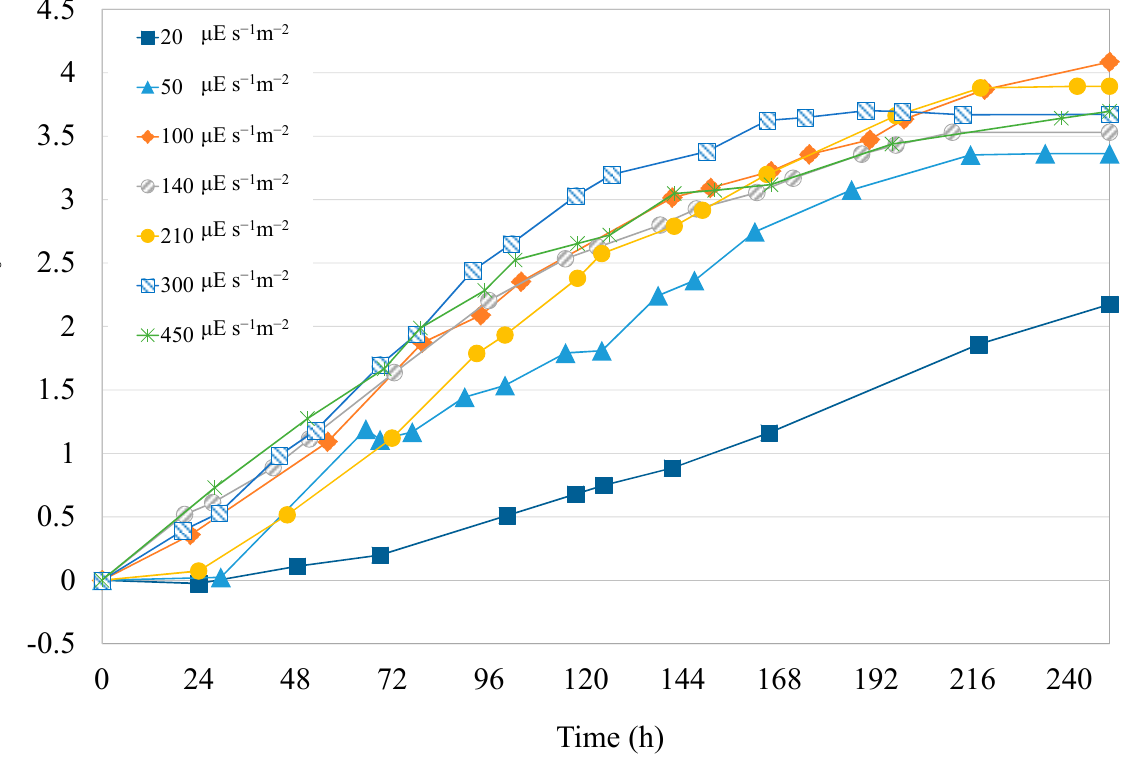
Figure 3. Growth of microalga Nannochloropsis gaditana at 25 °C in the quasi-isoactinic photobioreactor under different light intensities.